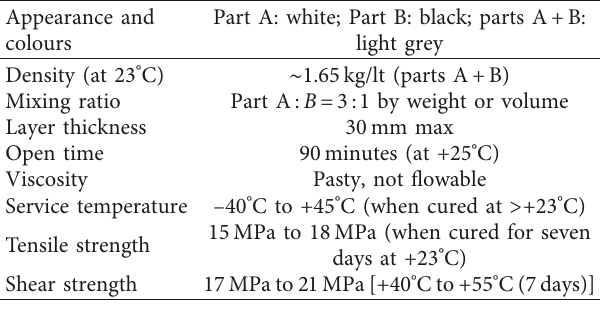
Table 5: Sikadur ® -30 LP (two-part epoxy impregnation resin).